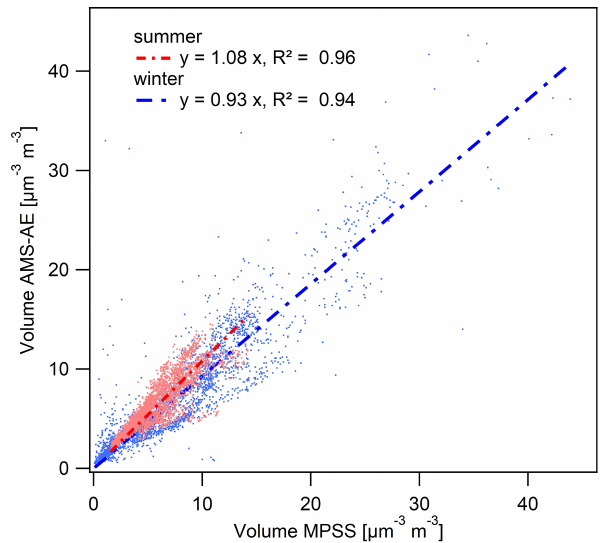
Figure 1. Comparison between the AMS-AE and MPSS measure- ments during both